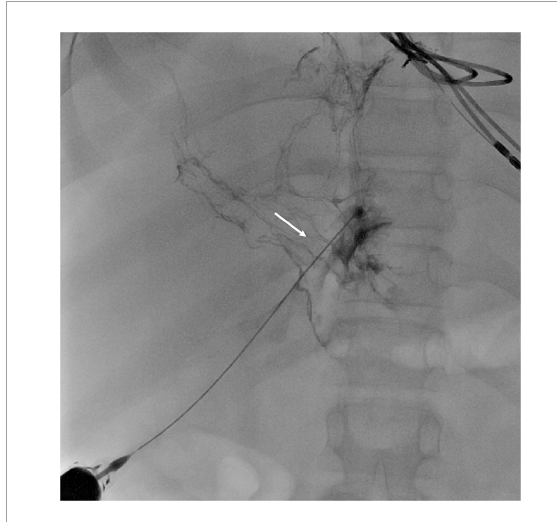
FIGURE6 Liver lymphangiography in a Fontan patient with protein losing enteropathy: note the dilated lymphatics in the peri-portal area draining toward the gut (white arrow).